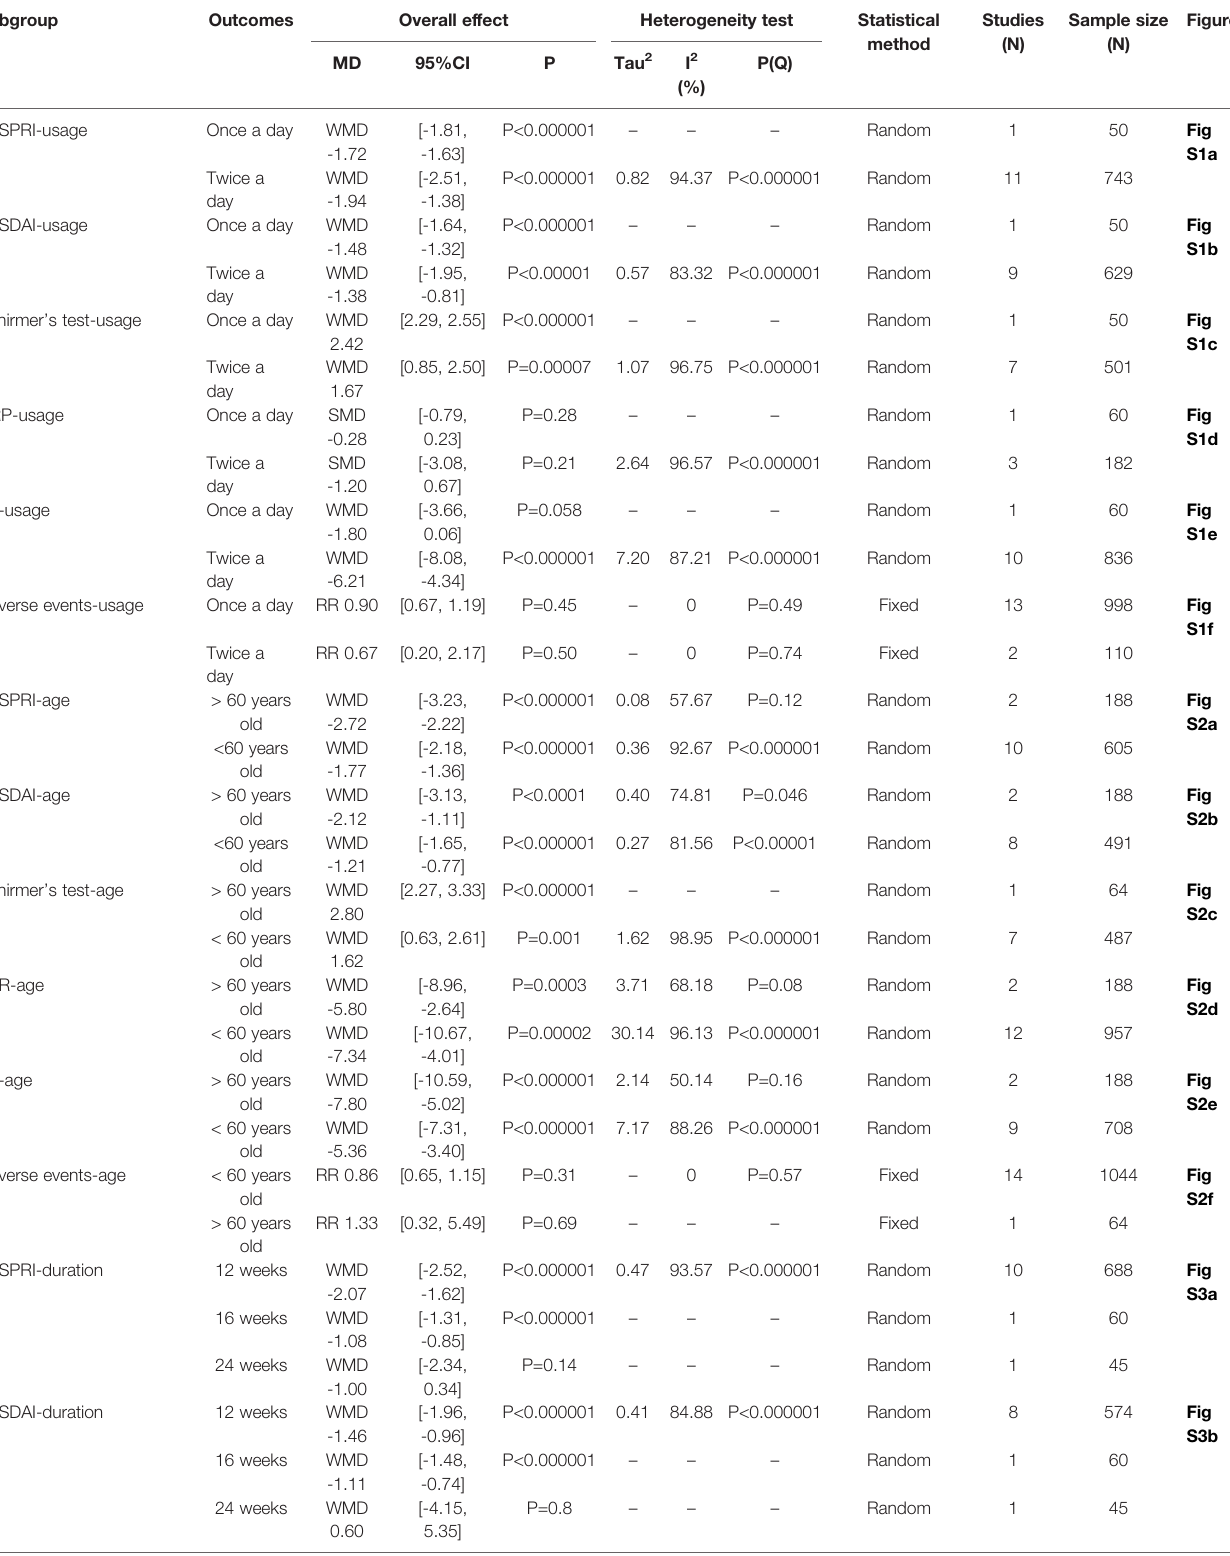
TABLE 2 | Subgroup analysis